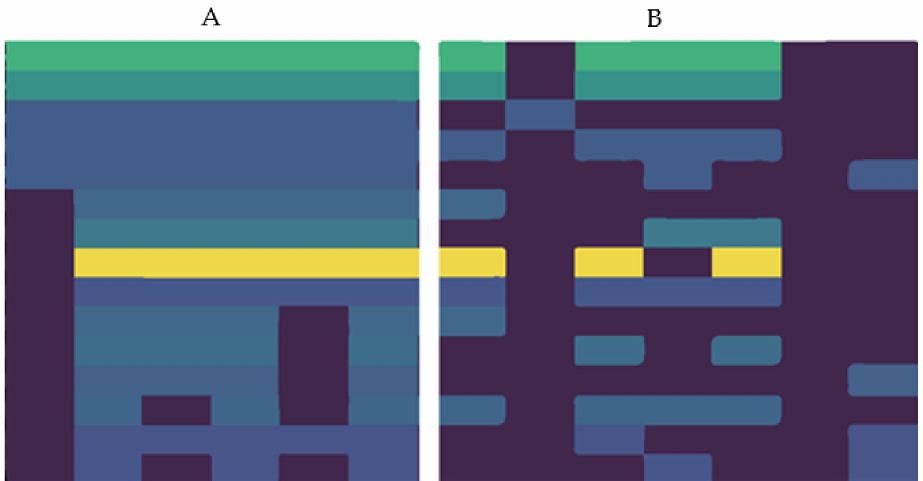
Figure 5. Patterns of the three clusters (epigenetic tri-clusters). ( A ) The marks are represented by columns, where rows represent clusters. ( B ) Columns represent cancer types, while rows represent clusters. Fold ratio is computed as the ratio of the genes count to the clusters in the